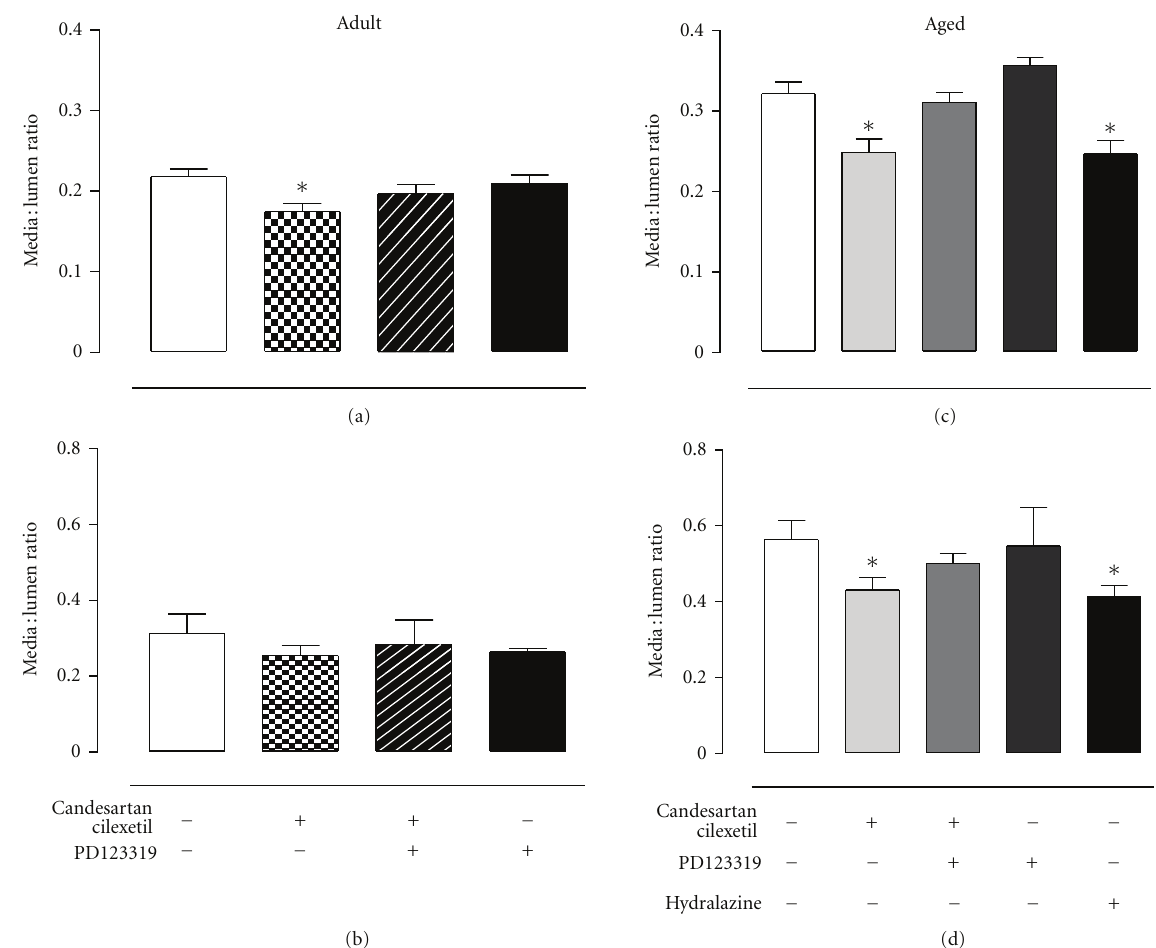
Figure 6: Media to lumen ratio of (a) aortic and (b) intramyocardial vessels of adult SHRs treated with vehicle (control, n = 6), candesartan cilexetil (2mg/kg/day) alone ( n = 7) or in combination with PD123319 (10mg/kg/day, n = 7) or PD123319 alone ( n = 7). Media to lumen ratio of (c) aortic and (d) intramyocardial vessels of senescent SHRs treated with vehicle (control, n = 10), candesartan cilexetil alone ( n = 9) or in combination with PD123319 ( n = 9), PD123319 alone ( n = 4), or hydralazine (30mg/kg/day, n = 7). ∗ P < 0 . 05 versus control (1-way